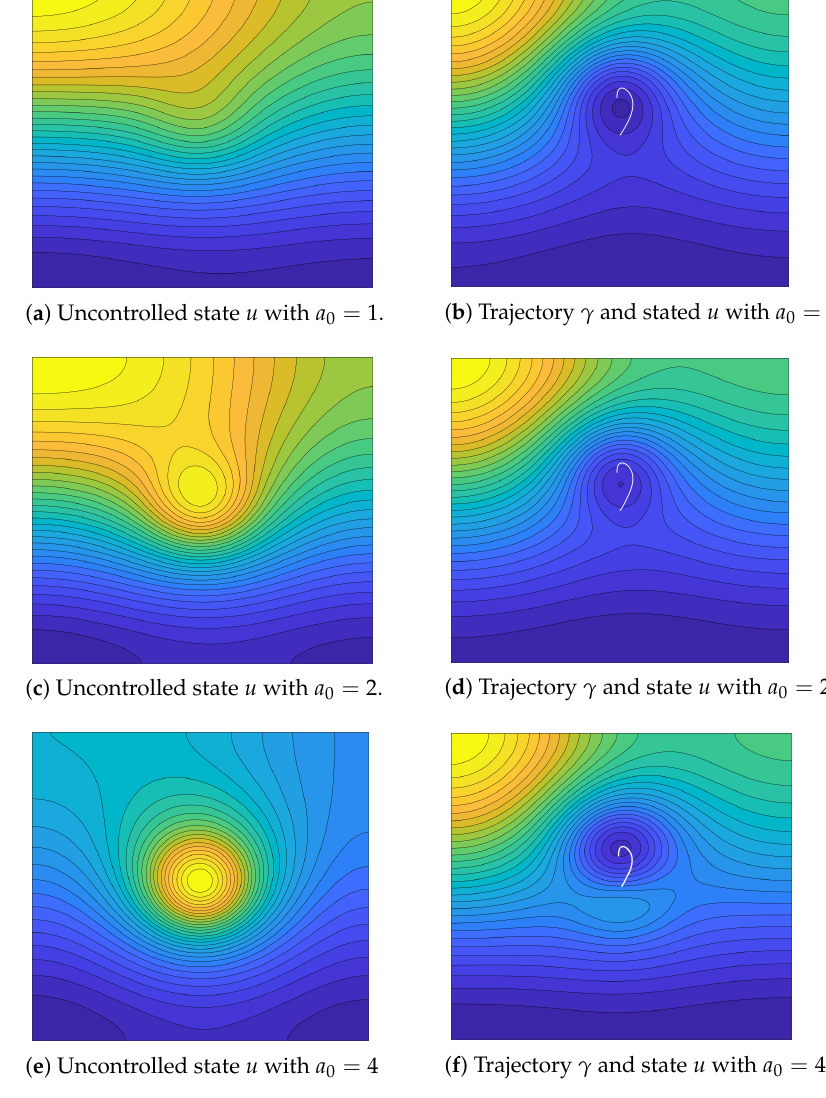
Figure 7. Uncontrolled state u ( a , c , e ) and Trajectory γ and controlled state u ( b , d , f ) at T = 2 for a ( x , t ) in (40) with a 0 = 1,2,4 with minimum and maximal values given in Table